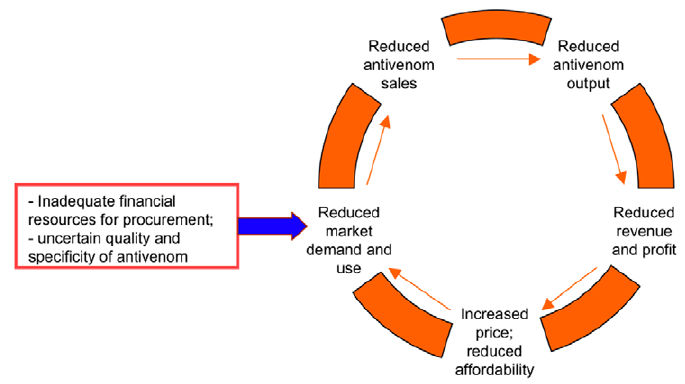
Figure 2. The self-perpetuating cycle responsible for the decline in antivenom production in sub-Saharan Africa. Inadequate financial support for antivenom production and variable quality have catalysed the collapse of the antivenom market, which is now characterised by deficient supply, deficient quality control, rising prices and poor profitability.